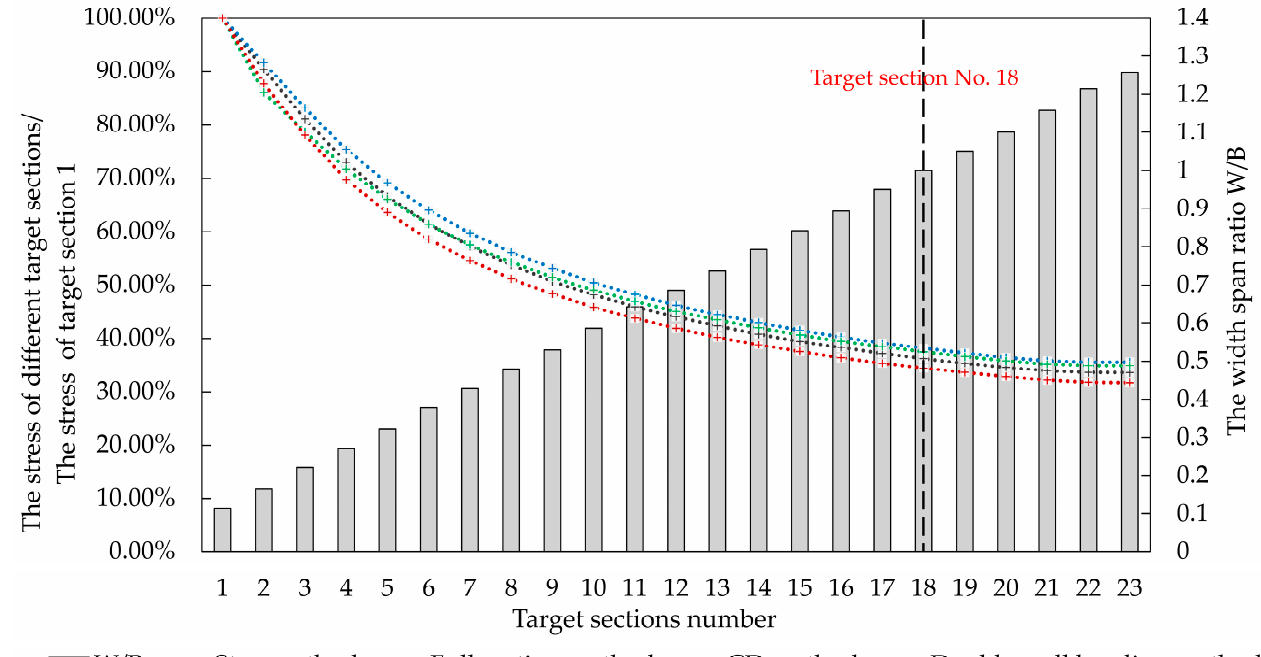
Figure 7. Relationship between the stress and the width span ratio of the central area of the middle rock pillar.